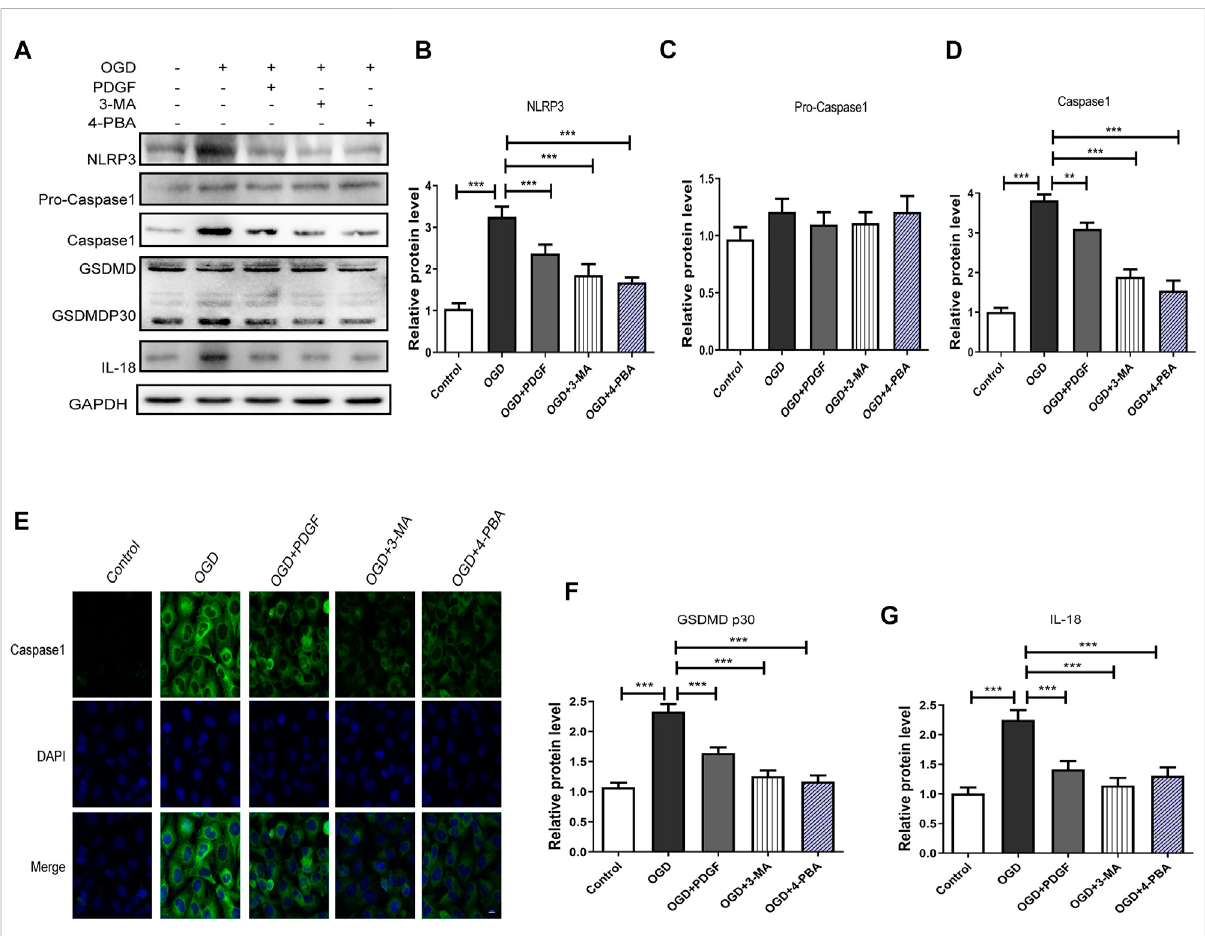
FIGURE 7 PDGF administration inhibits pyroptosis in OGD-treated HBMECs. (A) Representative western blot analyses of NLRP3, Pro-caspase1,